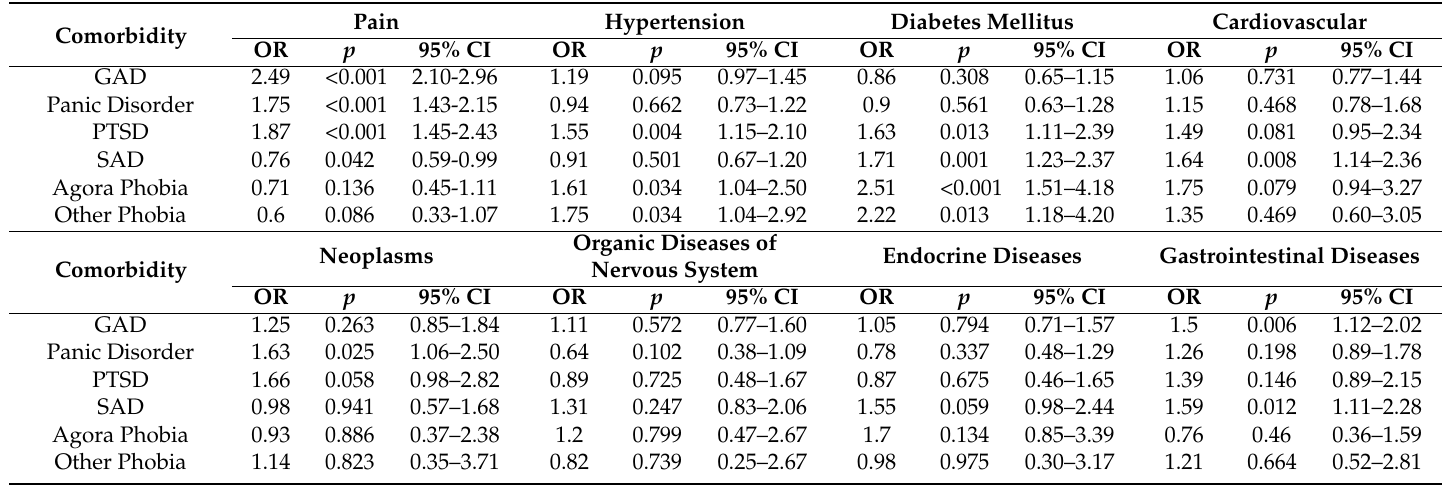
Table 5. Depression with co-occurring anxiety disorders; logistic regression of physical comorbidities, controlled for age, gender, type of depressive episode, number of depressive periods during the lifetime, and the length of the current depressive